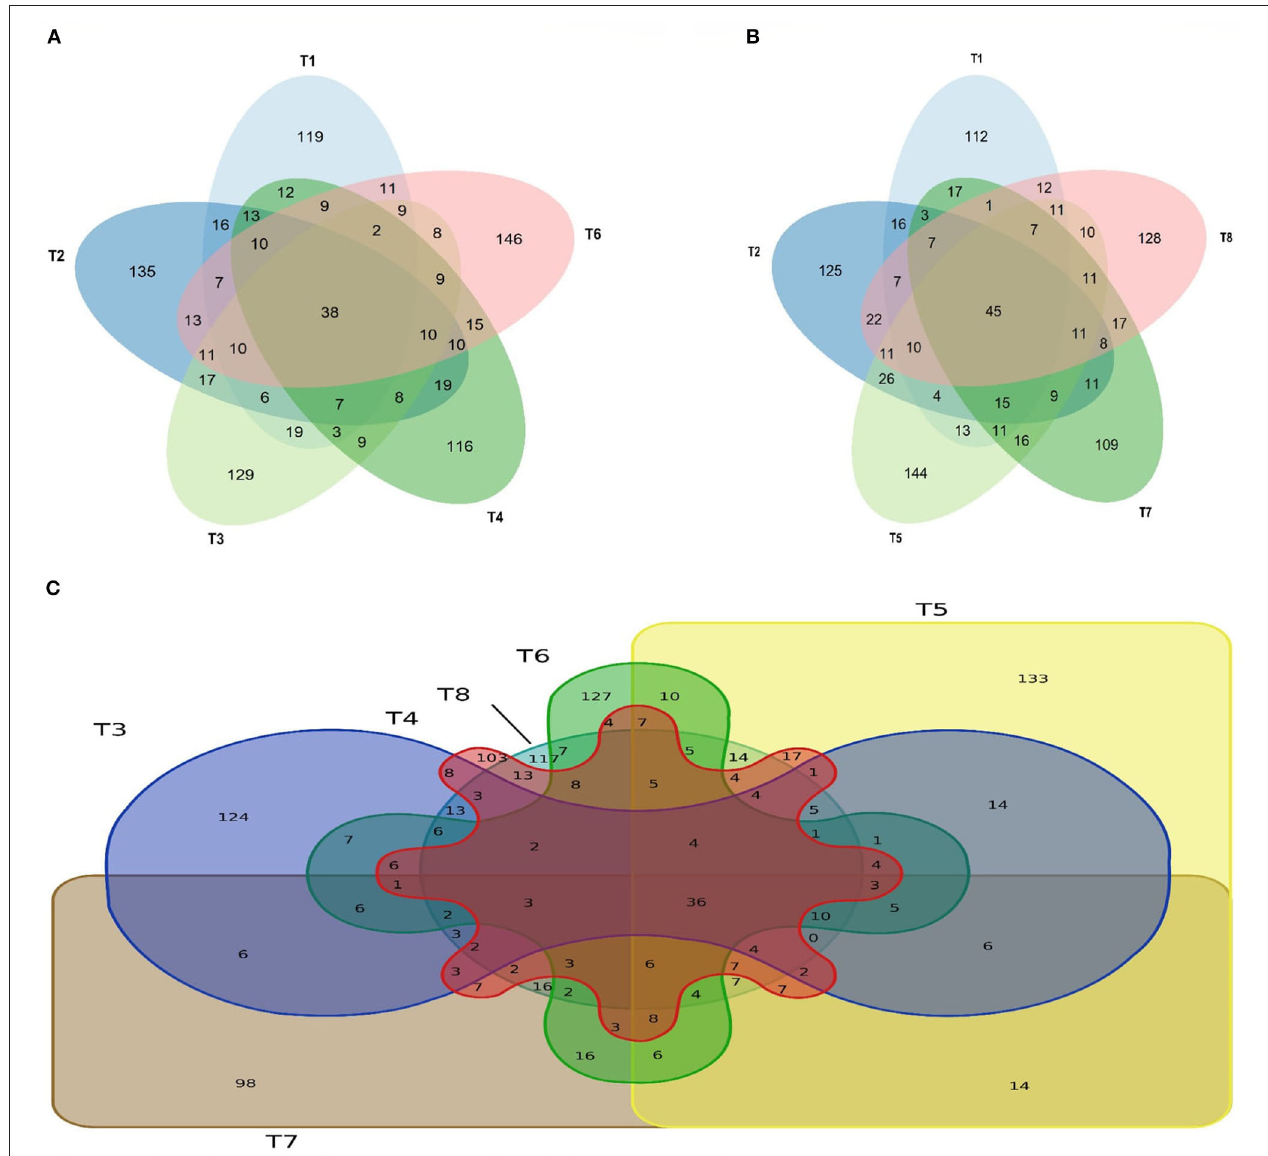
FIGURE 6 | Venn diagram (A) species richness of controls and postbiotic group, (B) species richness of controls and paraprobiotic group. T1 = Negative control (Basal diet), T2 = Positive control [Basalt diet + 0.01% (w/w) Oxytetracycline], T3 = Basal diet + 0.2% (v/w) postbiotic TL1, T4 = Basal diet + 0.2% (v/w)